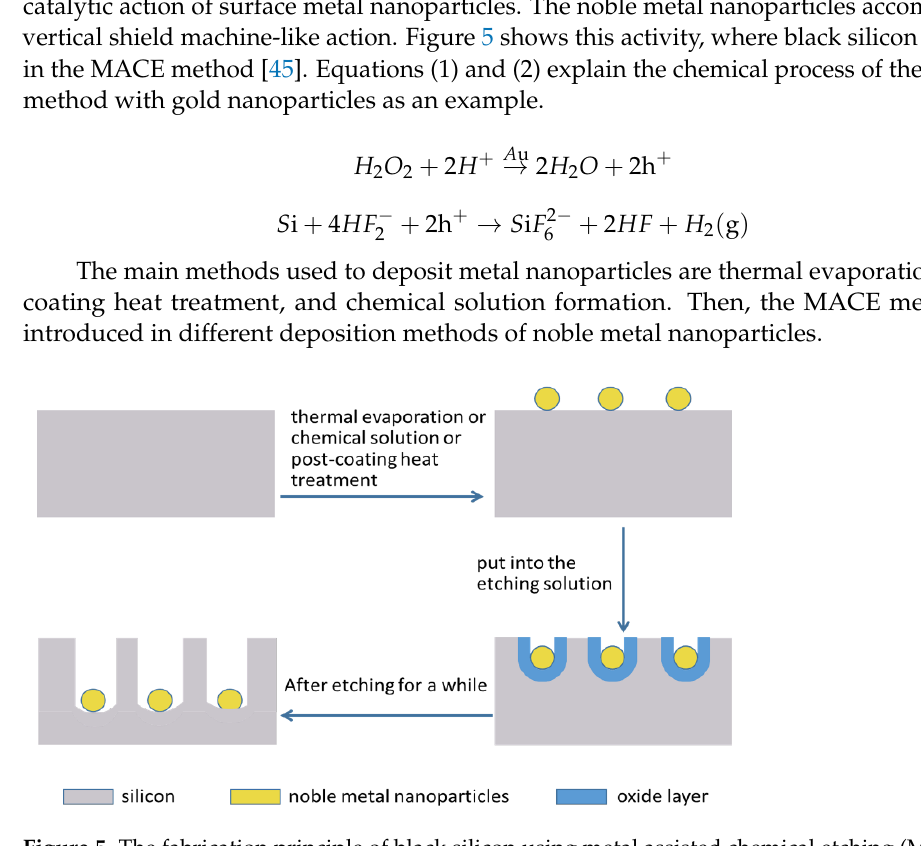
Figure 5. The fabrication principle of black silicon using metal assisted chemical etching